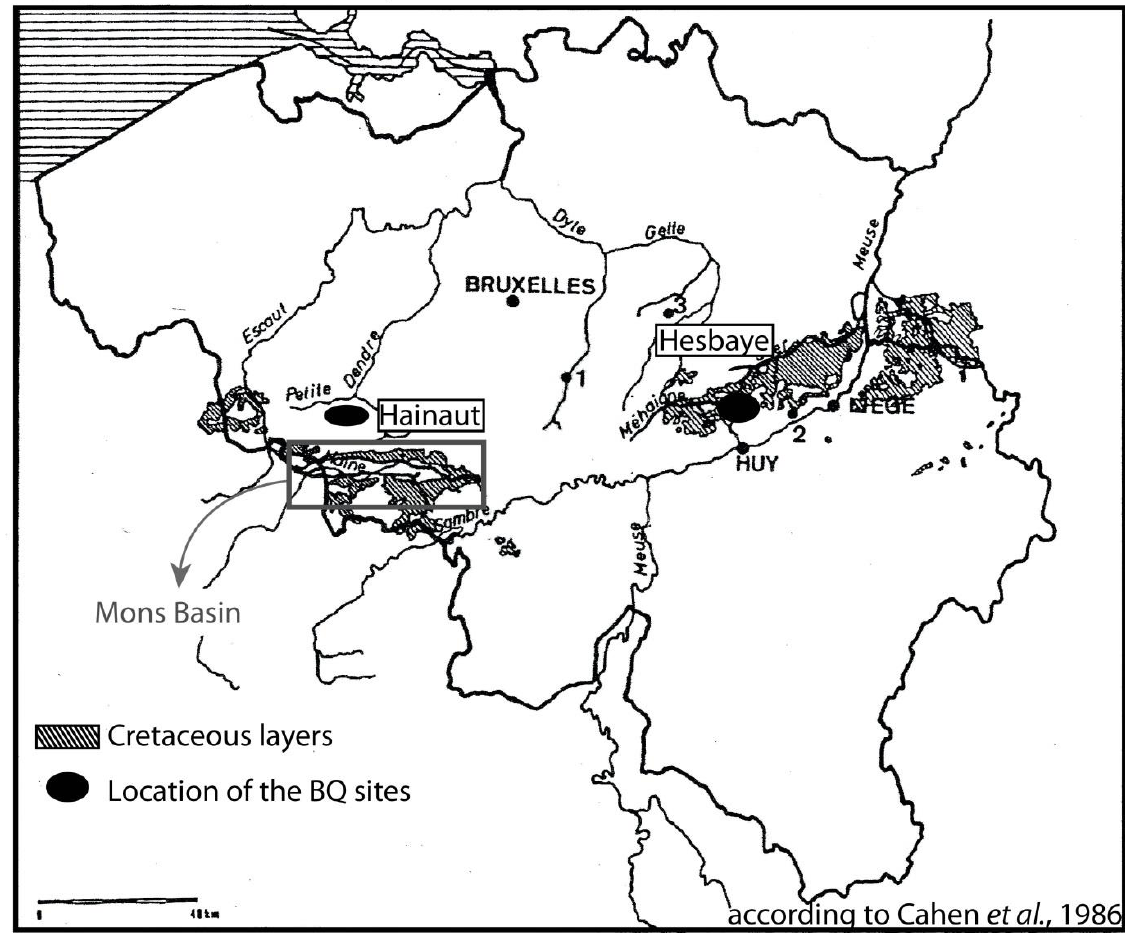
Figure 2. Location of the Cretaceous layers in Belgium that provide the siliceous raw materials exploited by the Early Neolithic